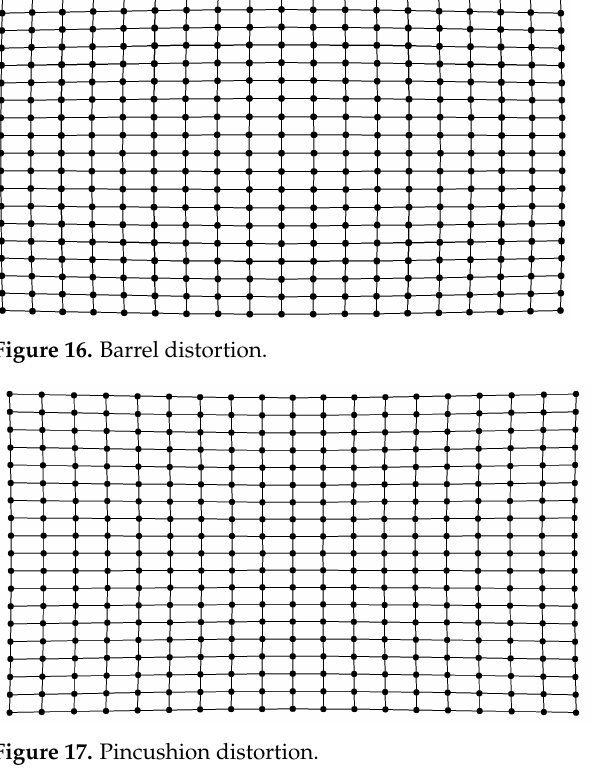
Figure 17. Pincushion